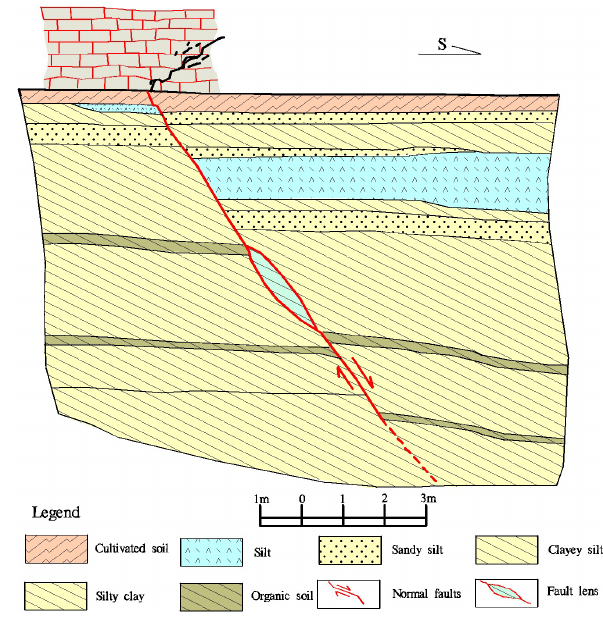
Figure 2. The profile of Gaoliying ground fissure according to trench